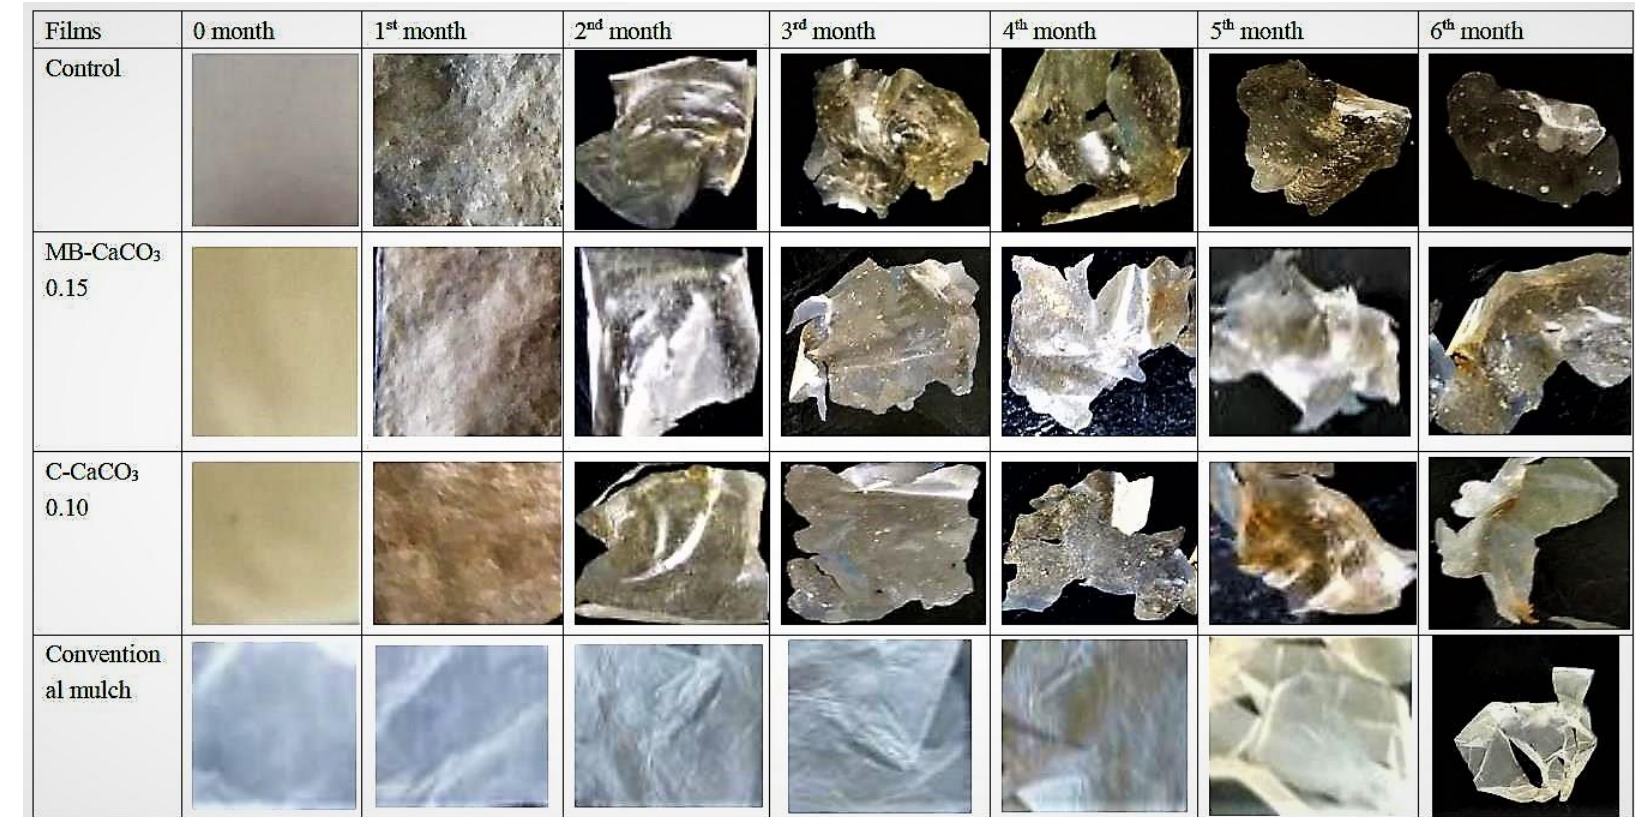
Figure 6. Changes in the appearance of films after 6 months of soil burial. 2